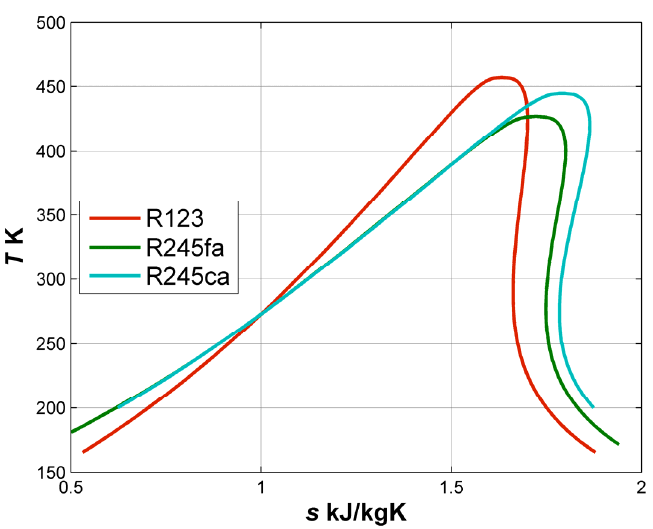
Figure 2. T-s diagram of the selected working fluids based on